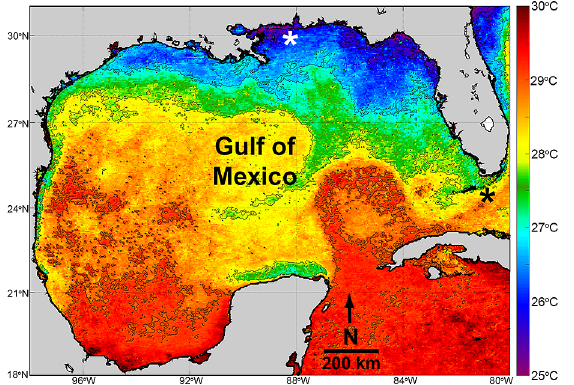
Fig 2. MODIS-Aqua image of sea surface temperature in the Gulf of Mexico during Fall. Sampling sites are represented by asterisks. Dauphin Island, AL (white asterisk) represents the Central Northern GoM, while Long Key, FL (black asterisk) represents the Southeastern GoM. This image is 10-day composite of sea surface temperature (4 km resolution. Level 2) from October 20 to October 30 2003. Isothermal lines were obtained using the “ m_countour ” function in MatLab. Image was obtained from the Ocean Color data website (http://oceandata.sci.gsfc.nasa.gov) and can be accessed at http://doi.org/10.5067/AQUA/MODIS_OC.2014.